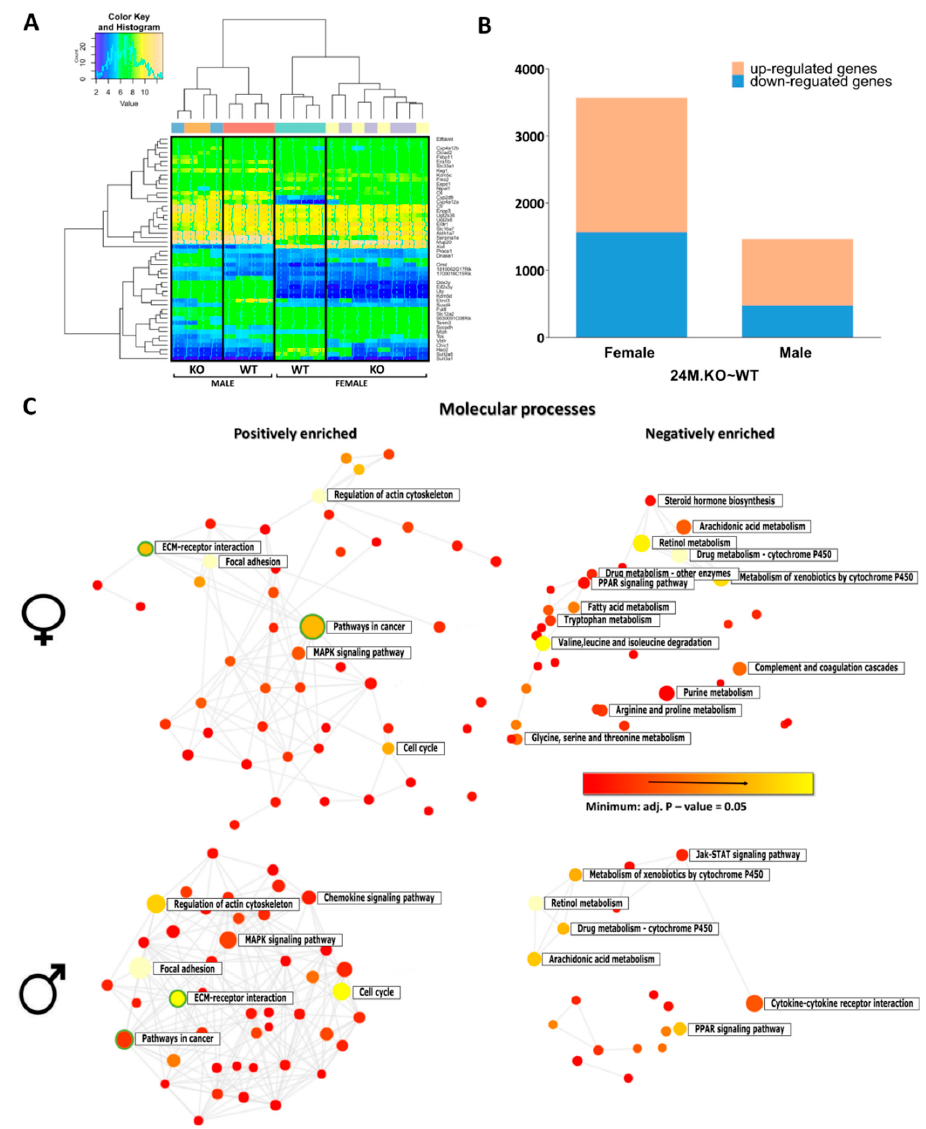
Figure 4. Target genes associated with blocked cholesterol synthesis. ( A ) Heat-map of top 50 DE transcripts that showed significant differences in at least one comparison: hierarchical clustering distinguished between the genotypes and sex of 24M KO (24M.KO~WT) mouse livers. ( B ) Stacked column plots with numbers of differentially up- and down-regulated sex-specific genes of 24M Cyp51 KO mice. ( C ) The functional enriched networks of up- and down-regulated DE genes in female and male 24M KO mice using NetworkAnalyst. The sizes of the nodes correspond to the number of DE genes within a particular molecular process. All pathway nodules are differentially expressed ( p < 0.05), the gradation rising from red to yellow (most enriched) in the network of positively (left) and negatively (right) enriched molecular processes. Circles representing cancer pathways and ECM-receptor interaction are surrounded by green lines.